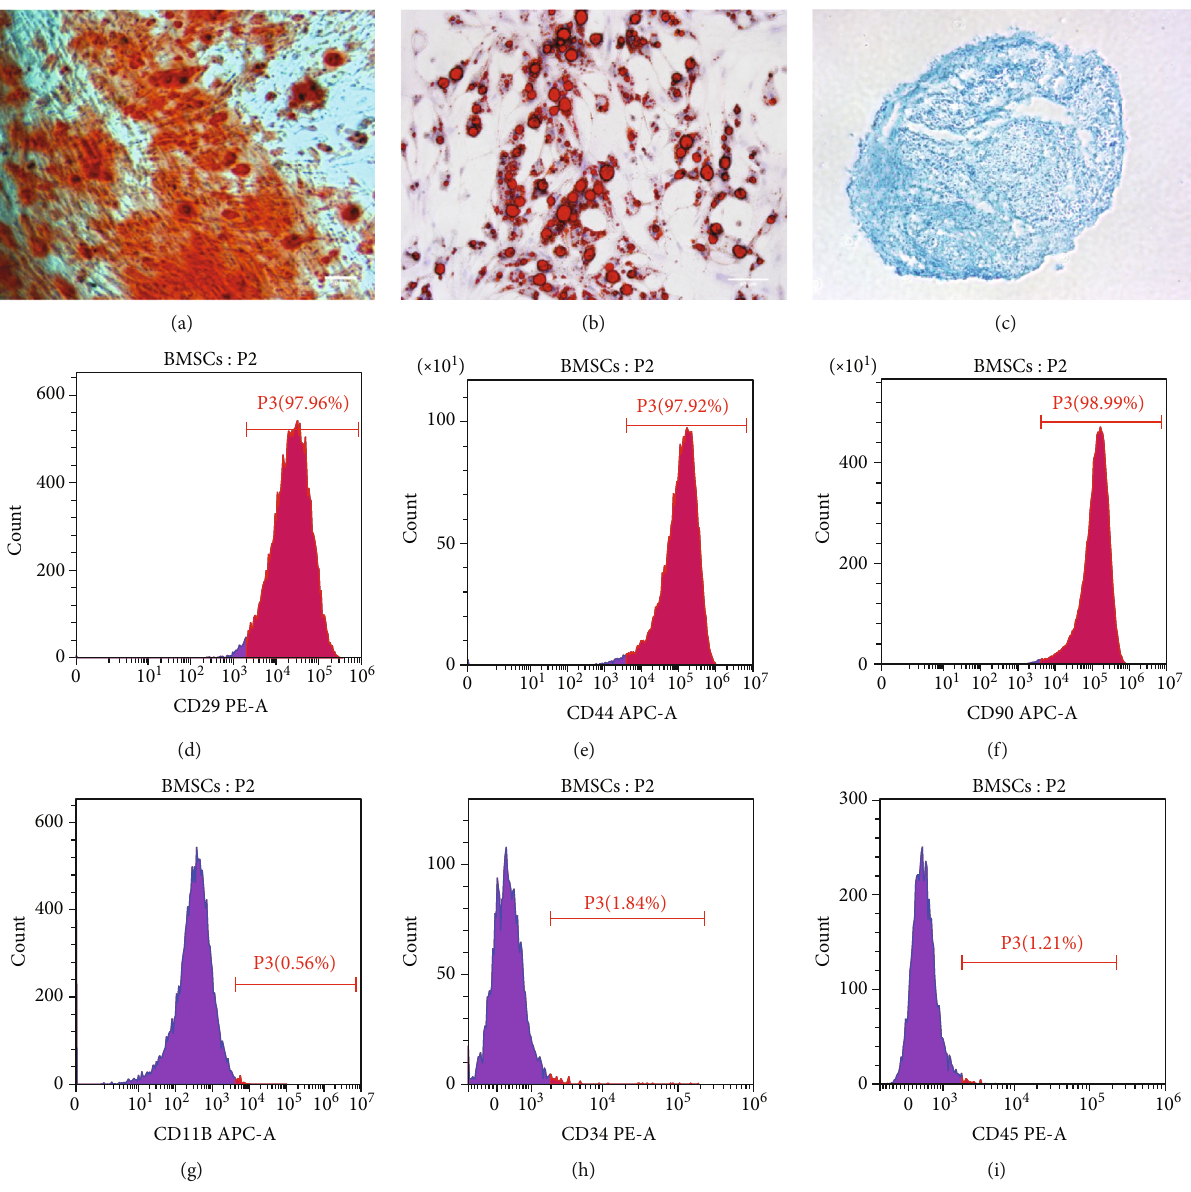
Figure 1: Multiline di ff erentiation and surface markers of BMSCs. (a) Osteogenic di ff erentiation. The Alizarin Red staining result showed that the BMSCs formed a massive red calcium nodule after three weeks of osteogenesis induction. (b) Adipogenesis di ff erentiation. After three weeks of adipogenesis induction, many red lipid droplets can be seen in the cells. (c) Chondrogenesis di ff erentiation. The Alcian blue staining of chondrogenic pellets con fi rmed the accumulation of extracellular matrix proteins in the chondrogenic pellet. (d – i) The cells positively express CD29, CD44, and CD90, while they have negative expression of CD11b, CD34, and